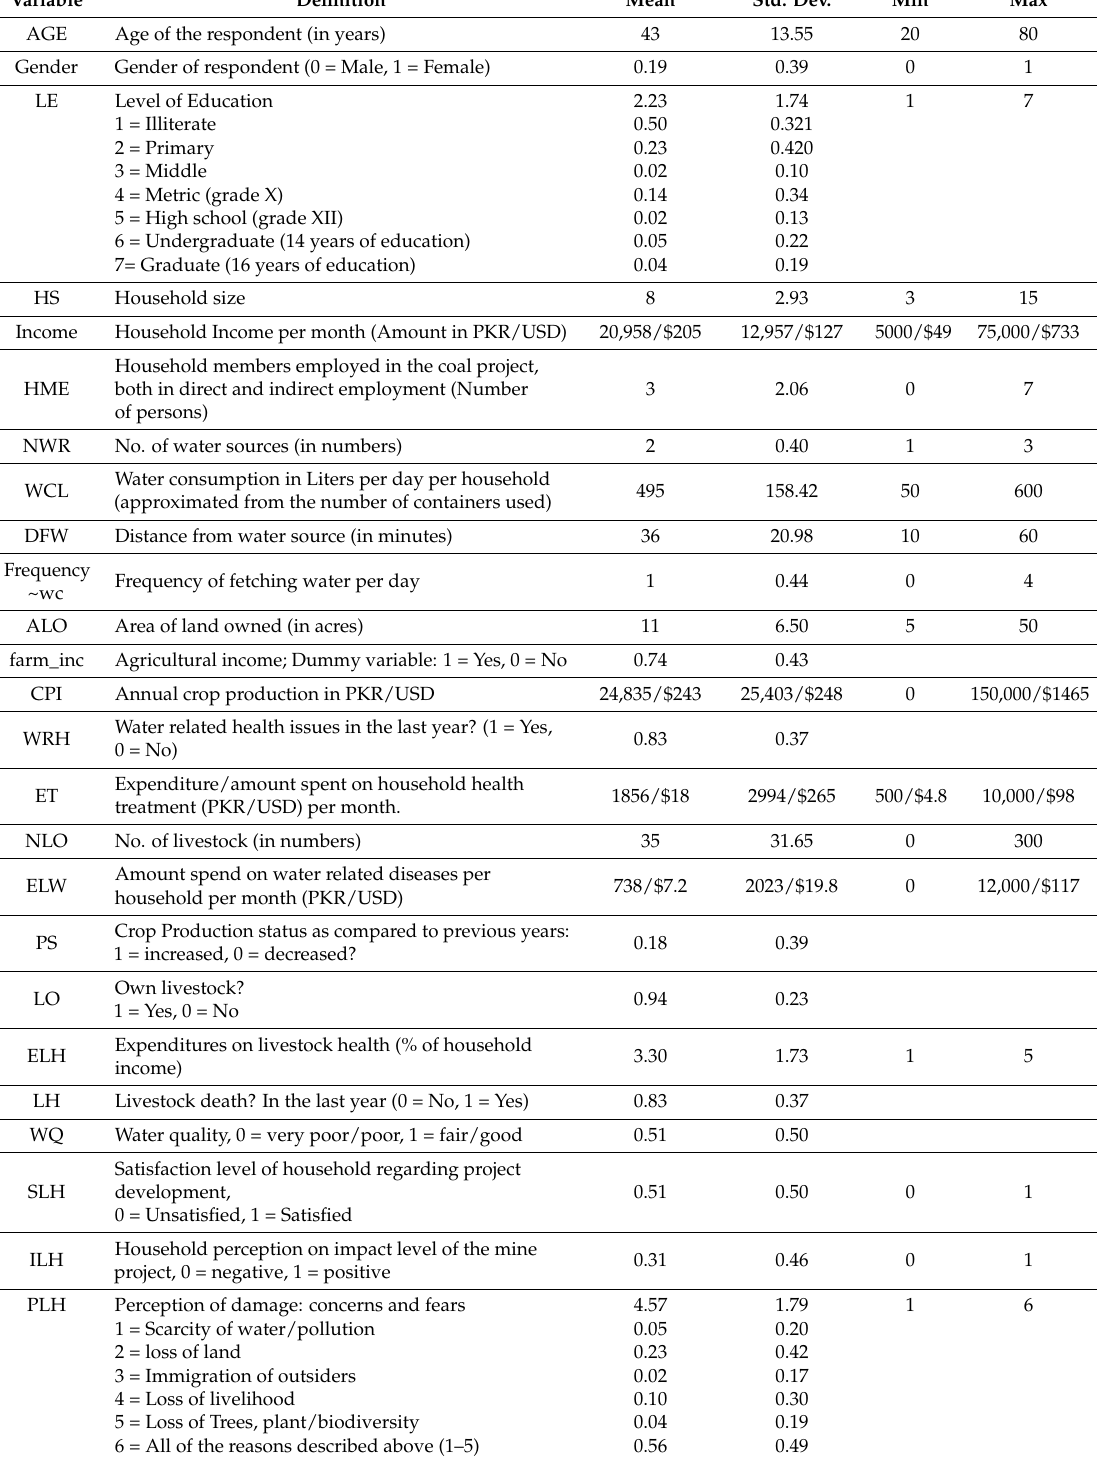
Table 1. Description and statistics of data